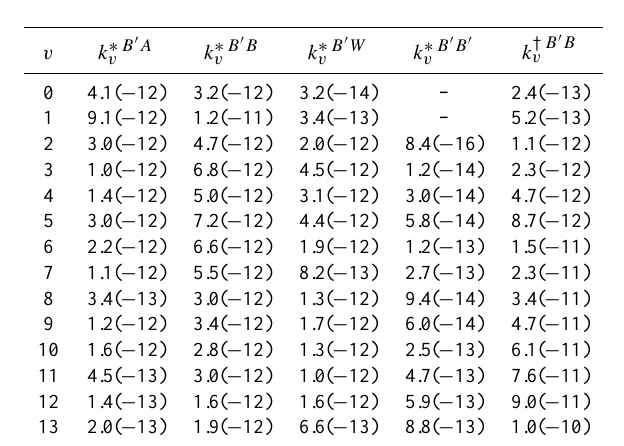
Table 4. Applied rate coefficients in Eq. (8d).